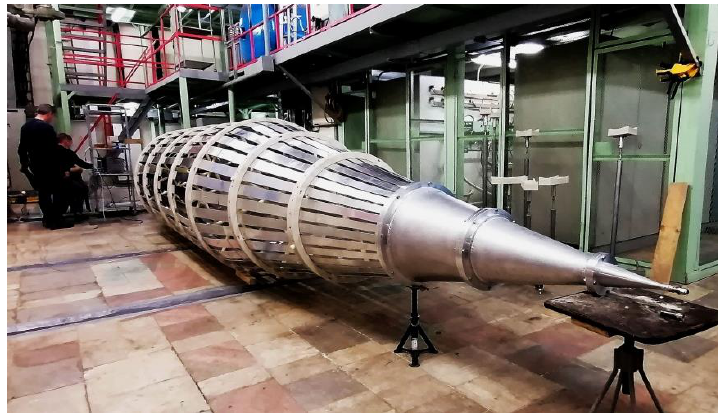
Figure 10. “Gigantic” coaxial line during its testing in KROT facility room.